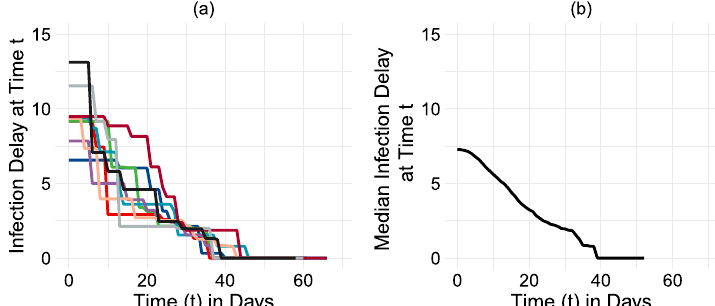
Fig. 6 Illustrative example of infection delay median pipeline for a single hexagon cell, using only 10 outbreaks for visualisation (real analysis uses 2598 outbreak scenarios). From left to right: a the infection delay curves are calculated for each outbreak location; b the median of those curves are taken at every time t to create a general characterisation of lockdown effectiveness in the